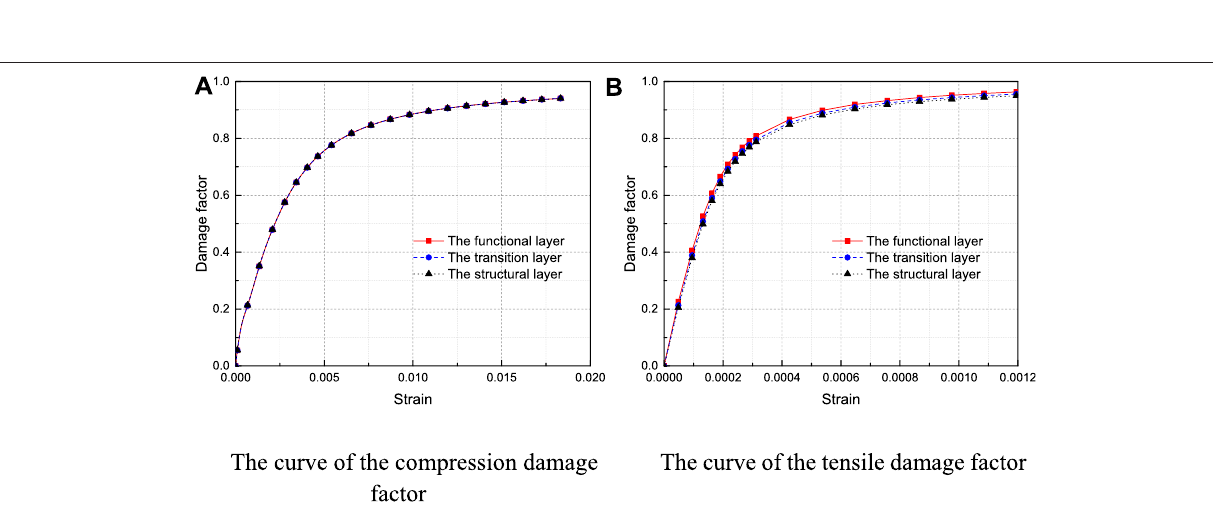
FIGURE15 | The uniaxial stress-straincurveofthe FGC. (A) The uniaxial compression stress-strain curve of theFGC. (B) The uniaxial tensile stress-strain curve of the FGC.